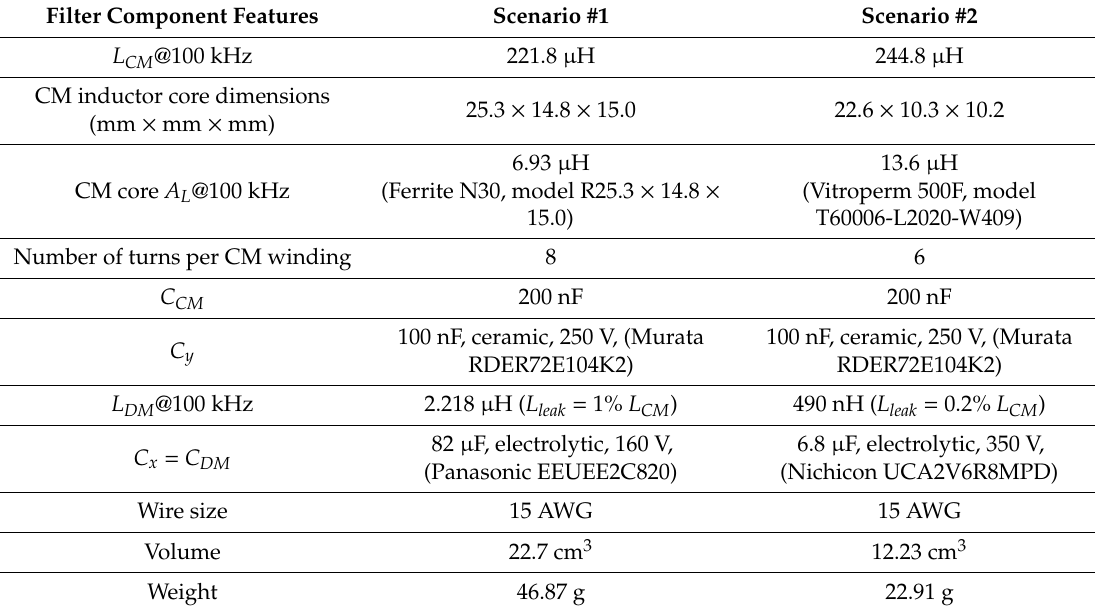
Table 3. Results obtained in the three scenarios for the chosen case